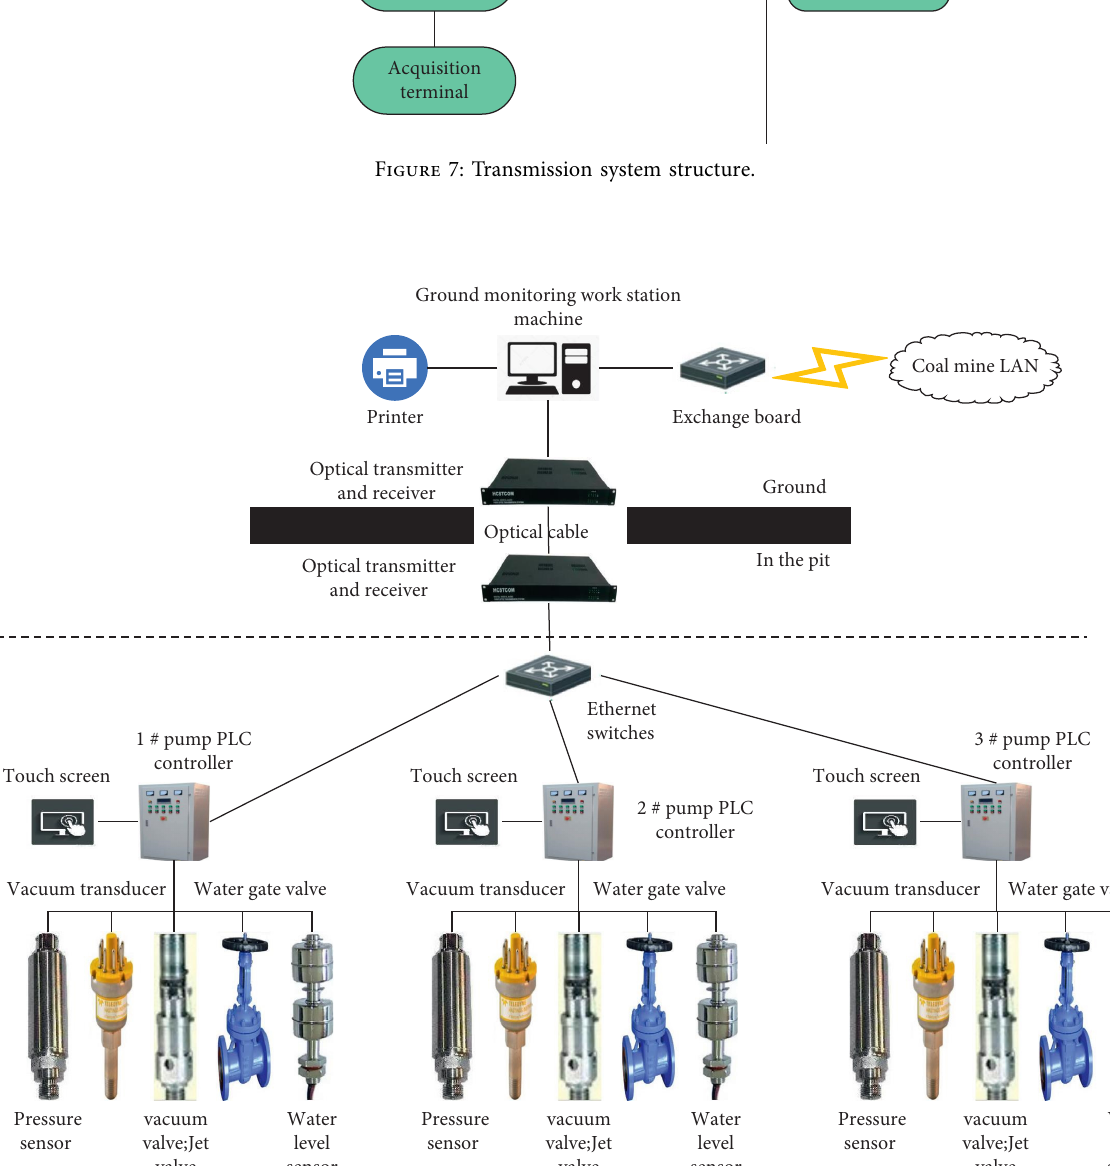
Figure 8: 'e overall structure of the control